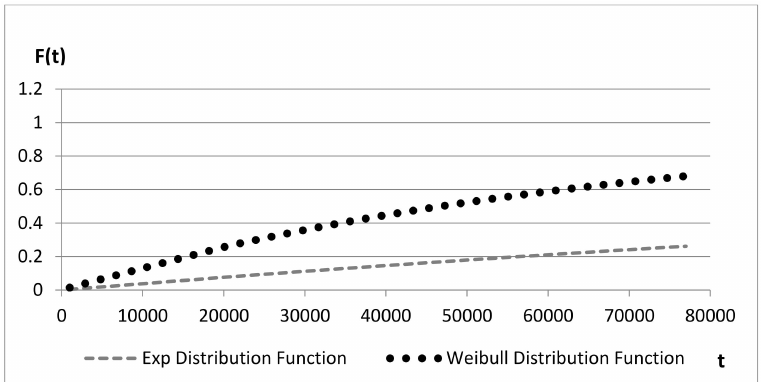
Figure 10. Comparison of cumulative distribution functions F ( t ) for